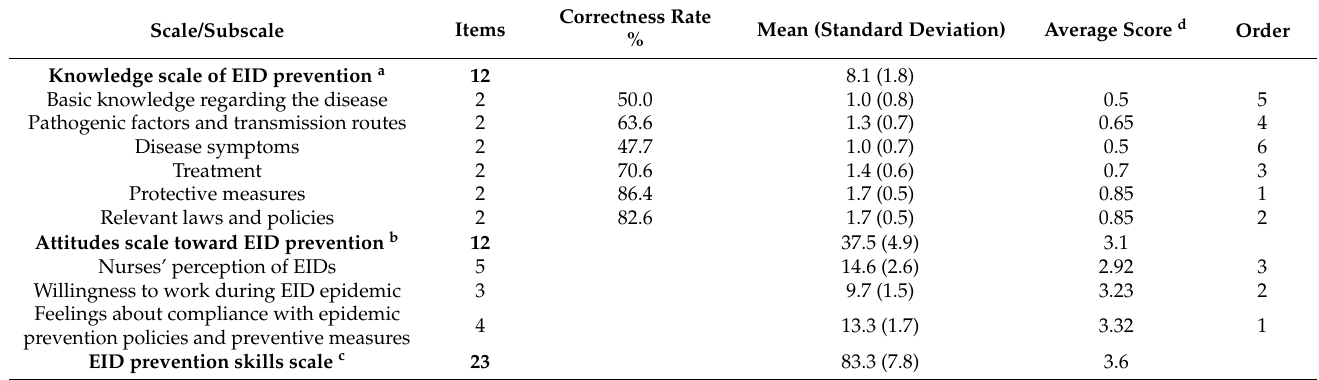
Table 2. Analysis of questionnaire scores on the competency in EID prevention among long-term care facility nurses ( N =